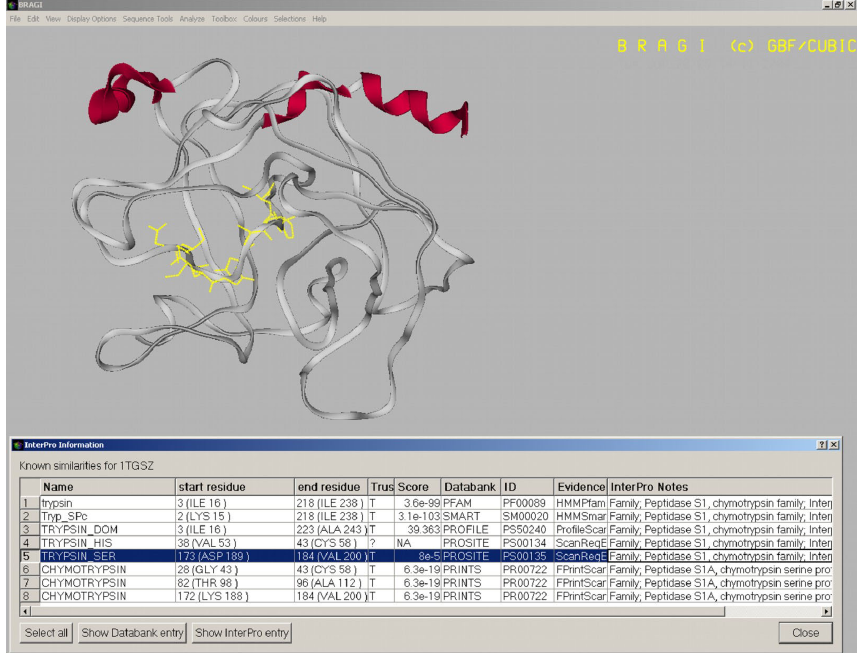
Fig. 5 Screenshot of the 3D-viewer BRAGI [11]. Domains as evaluated from the InterProScan tool are shown in the “InterPro Information” window. The user queried the PDB entry, 1TGS and chose the trypsin domain (Nr. 5, TRYPSIN_SER) from this window. The requested information is yellow highlighted in the 3D structure (main